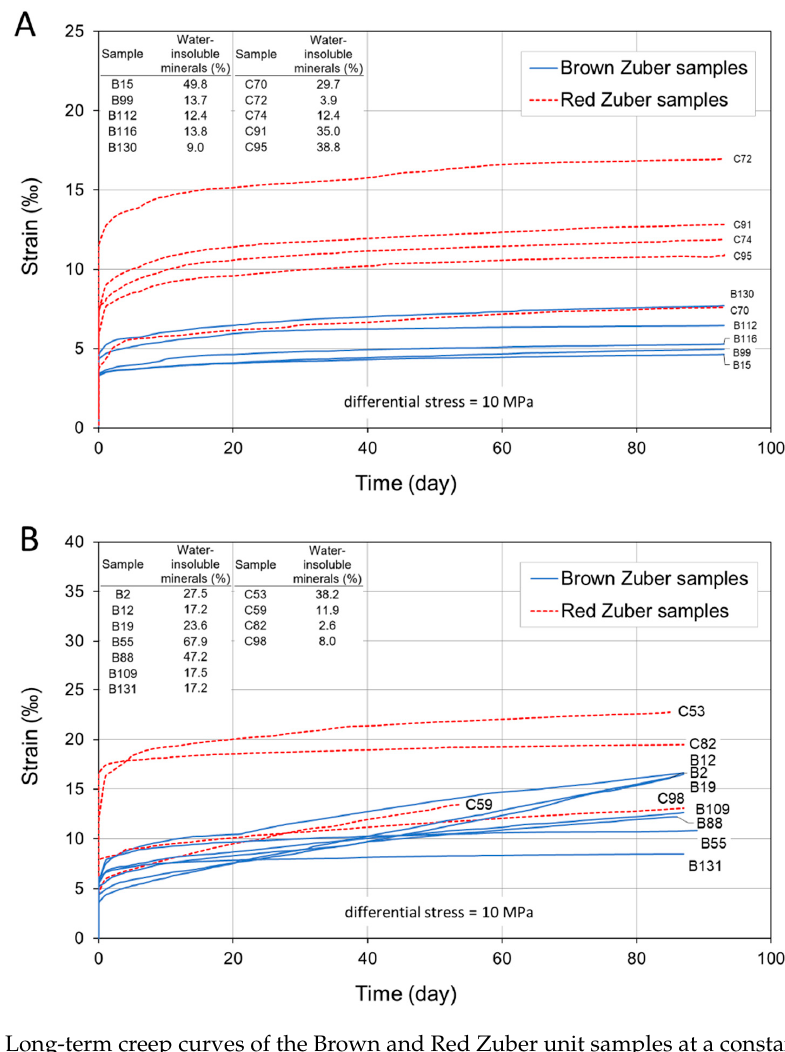
Figure 17. Long-term creep curves of the Brown and Red Zuber unit samples at a constant pressure and at room temperature ( A ) and at a temperature of 60 °C ( B ) (according to [58]).